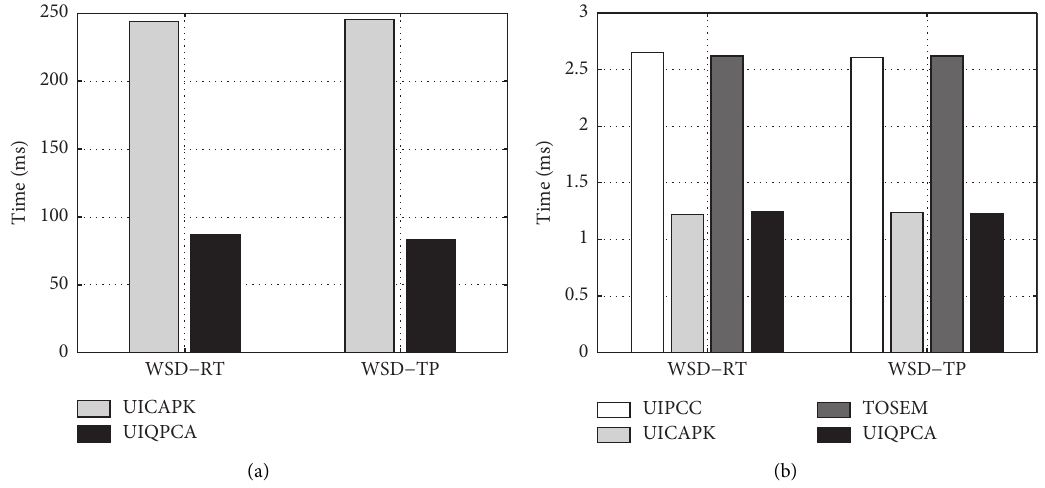
Figure 8: Computation Time. (a) Clustering time. (b) Prediction